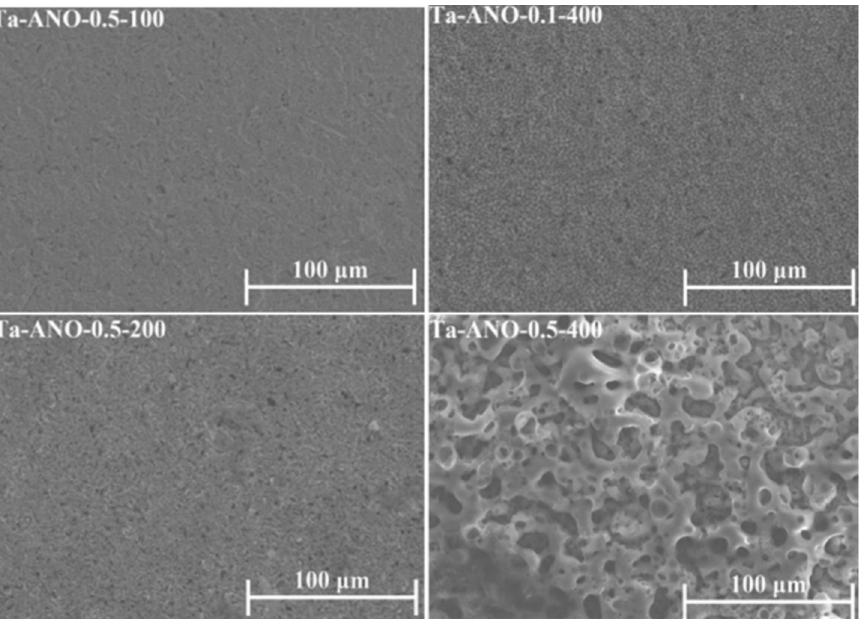
Figure 13. Surface morphologies of Ta 2 O 5 prepared by MAO under different conditions: 0.5 M K 2 SiO 3 at a range of 100 to 400 V, and 0.1 M K 2 SiO 3 at 400 V. Adapted with permission from [62]. Copyright 2013 Elsevier.